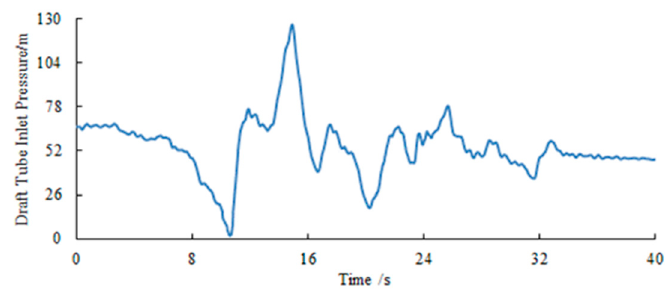
Figure 10. Pressure extreme process line of spiral case under simultaneous load rejection.